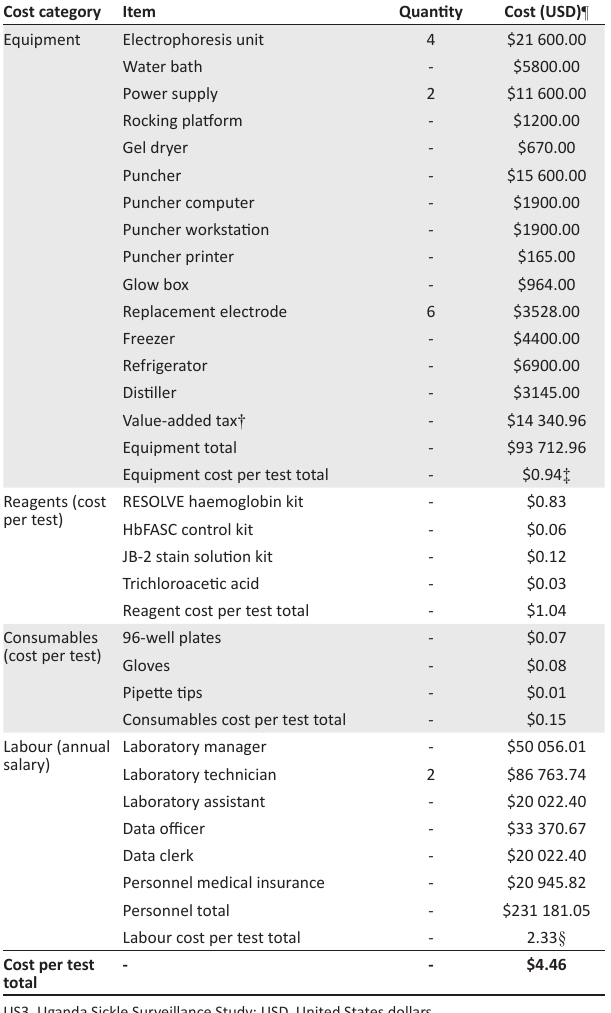
TABLE 5: Costs for sickle cell screening and testing for 99 243 children in Uganda from the US3 project over 13 months, February 2014 to March 2015. Cost category Item